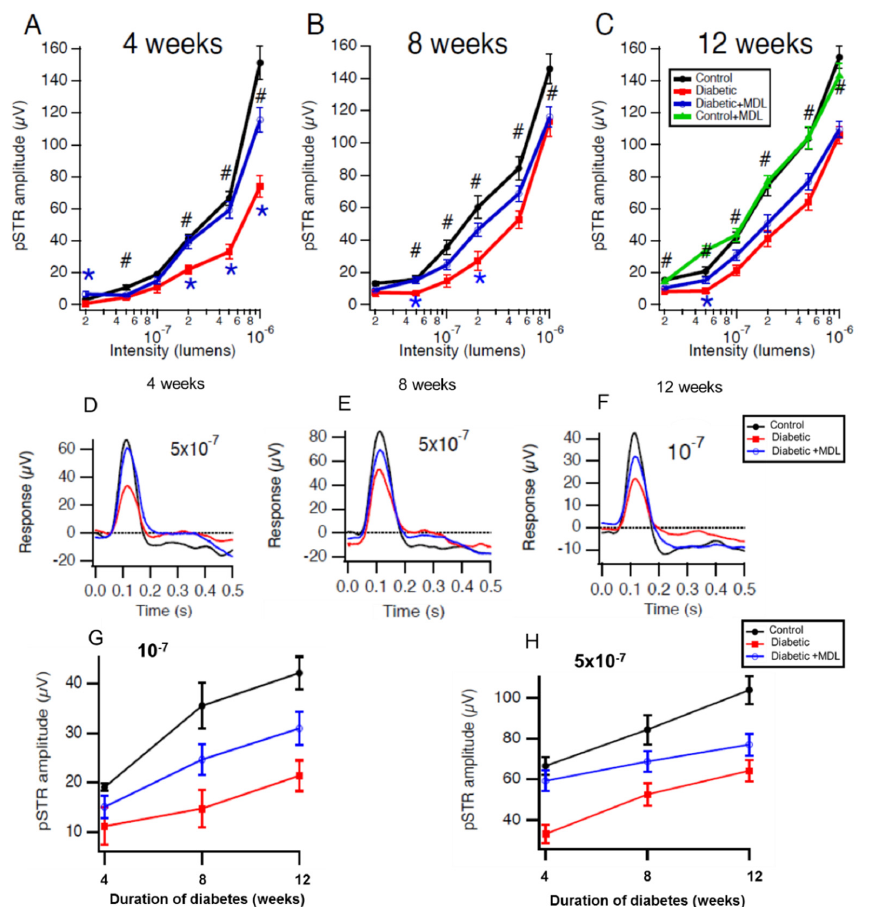
Figure 3. Treatment with MDL 72527 preserved inner retinal function in the diabetic mice. ( A – C ) Studies by dark-adapted electroretinography showing the positive scotopic threshold responses (pSTRs, a sensitive measure of inner retinal function). The pSTRs are significantly reduced in diabetic animals (4, 8, and 12 weeks post diabetic). Treatment with MDL 72527 preserved the pSTR amplitudes in the diabetic group showing a partial rescue of inner retinal function with SMOX inhibition. Responses from vehicle-treated and MDL 72527 treated controls show no di ff erences in their pSTRs. Significant di ff erences at individual intensities are shown (t-tests with Holm-Bonferroni corrections for multiple comparisons; # p < 0.001, * p < 0.05). ( D – F ) Representative data showing responses at a single intensity in mice at 4, 8, and 12 weeks post diabetes. ( G , H ) Summarizing the e ff ects of duration of diabetes on pSTRs (at two di ff erent intensities). * diabetic vs diabetic + MDL, # diabetic vs Control. Number of animals per group are: Control (4), Diabetic (4), and Diabetic + MDL (7) for 4 weeks; Control (7), Diabetic (8), and Diabetic + MDL (12) for 8 weeks and Control (11), Diabetic (11), Diabetic + MDL